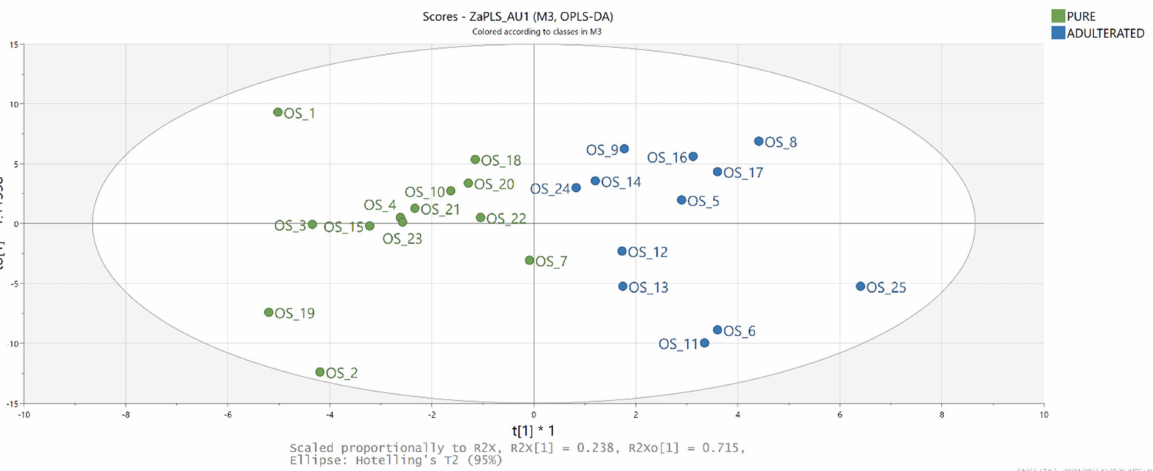
Figure 6. Score plot of OPLS-DA model built with NIR spectrometry data for discrimination between pure and adulterated pumpkin seed